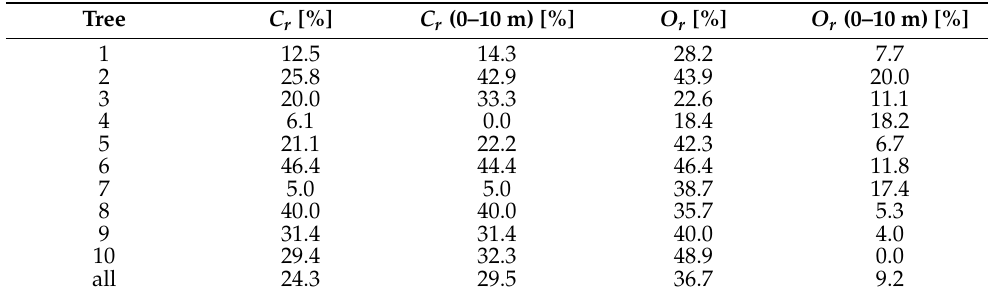
Table 3. Omission and commission error rates (Equations (4) and (5)) for each sample tree and for all trees, both for all branch whorls and for branch whorls at a height interval of 0–10m from the ground. Tree C r